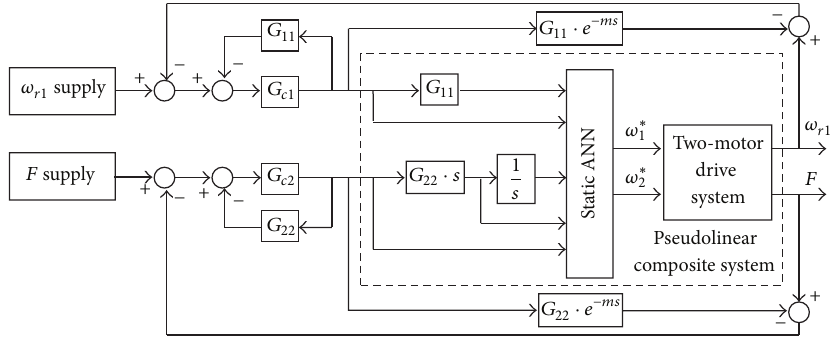
Figure 6: NNGI-SIM control